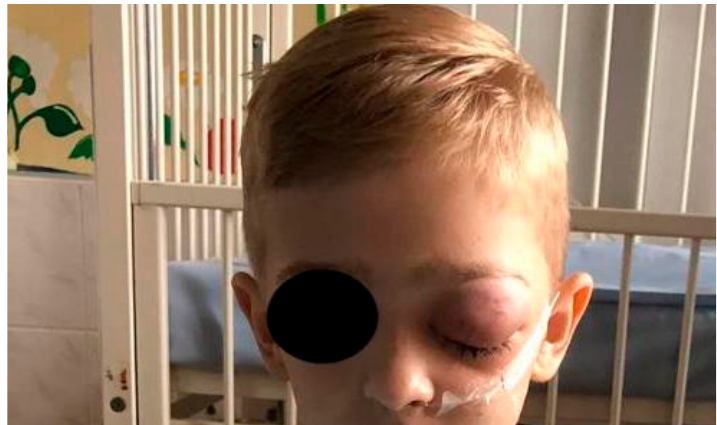
Figure 6. 7-year-old patient with orbital phlegmon on the left side.